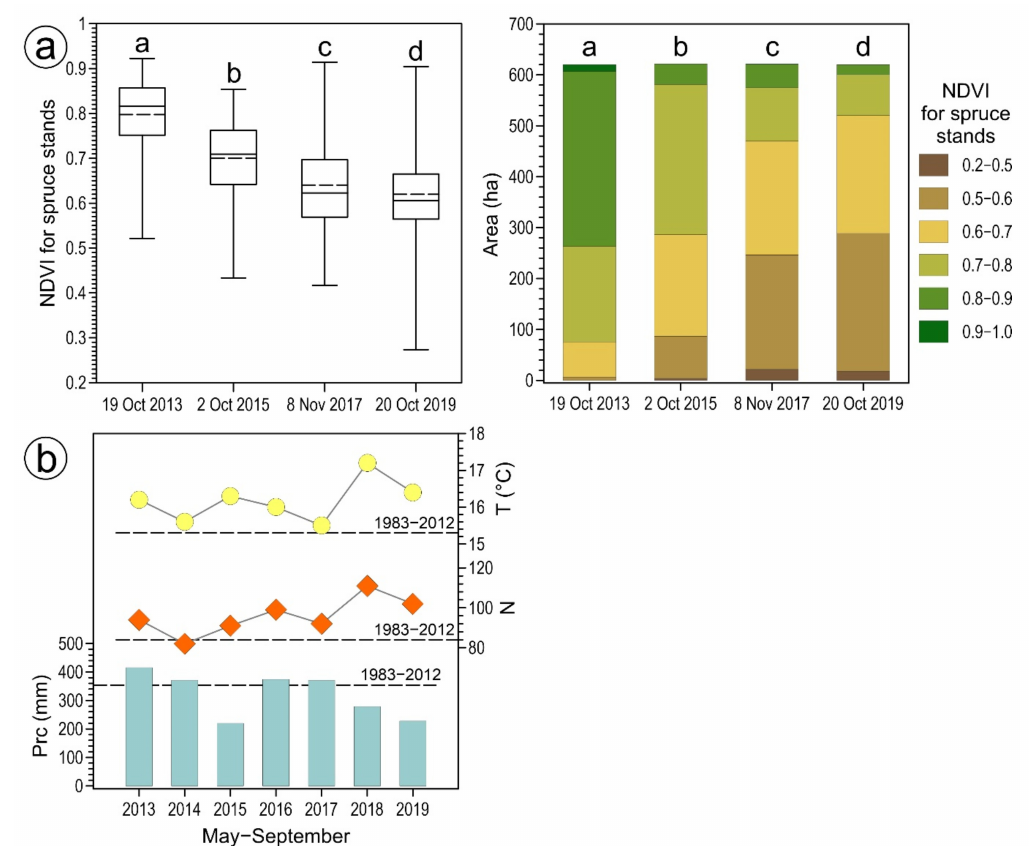
Figure 5. ( a ) Quantitative NDVI distributions for the studied spruce stand. The distributions marked by different letters were significantly different according to a λ Kolmogorov–Smirnov test at p < 0.01. The dashed line represents the mean value. ( b ) Weather data for the period of May–September in 2013–2019: total precipitation, Prc (mm); average daily air temperature, T ( ◦ C); number of days with average daily temperature ≥ 15 ◦ C, N. The dashed line represents the long-term average for 1983–2012.